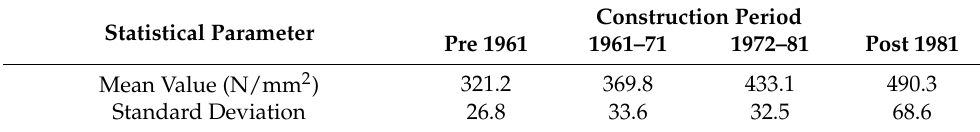
Table 7. Yield strength (f y ) of steel rebars in different construction